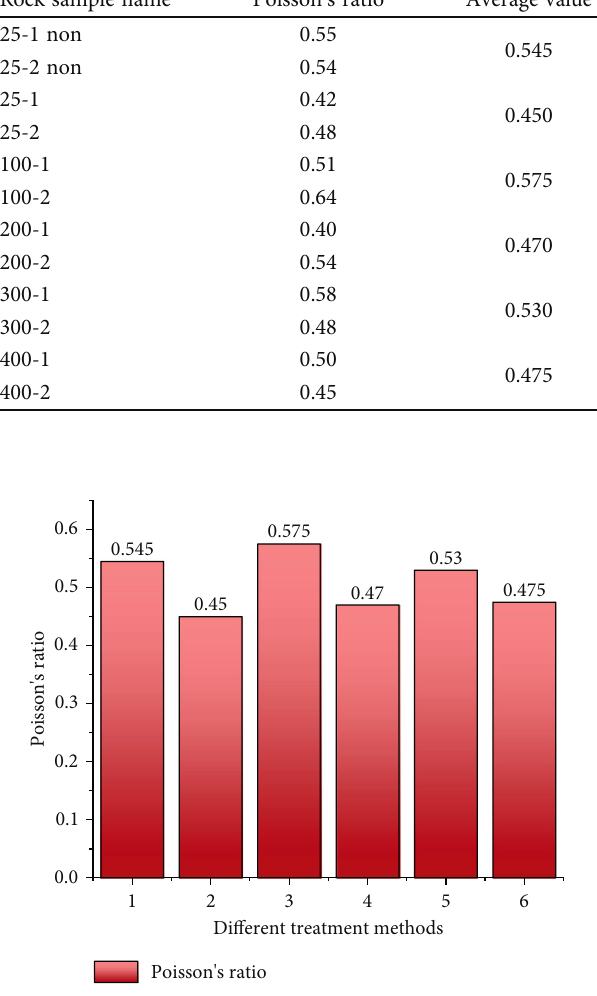
Figure 8: Poisson ’ s ratio of rock samples with di ff erent treatment